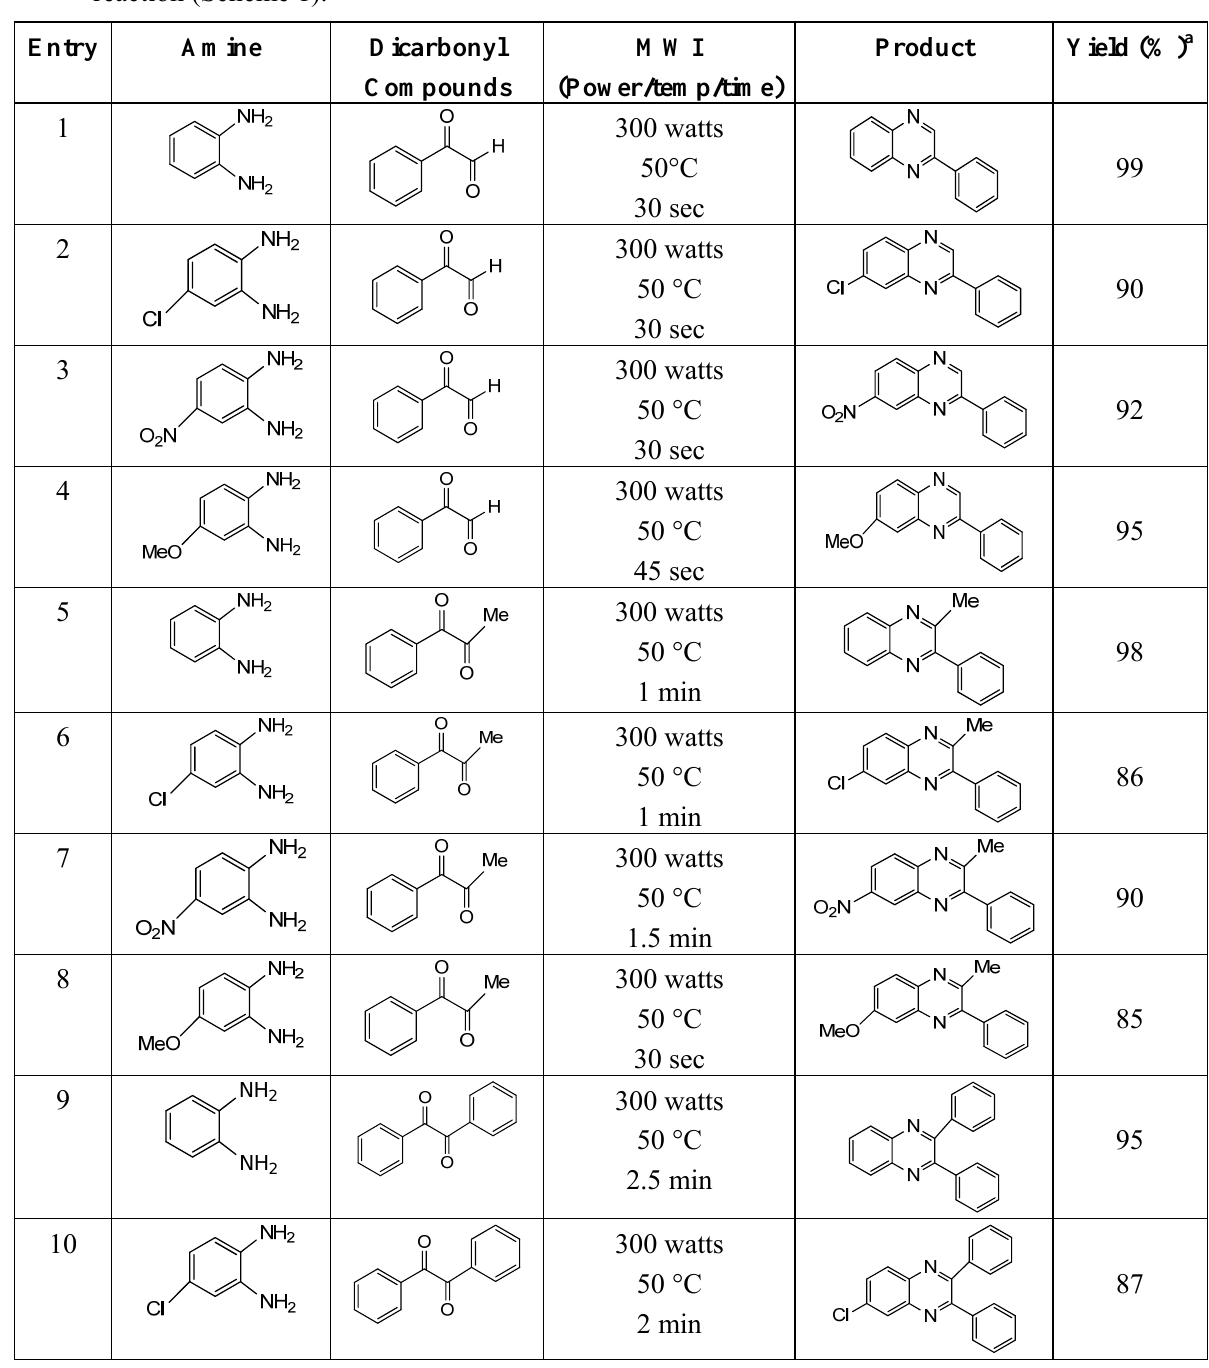
Table 2. Synthesis of quinoxalines via condensation of 1,2-diamines with 1,2-dicarbonyl compounds with iodine as the catalyst in water/ethanol (1:1) under microwave induces reaction (Scheme